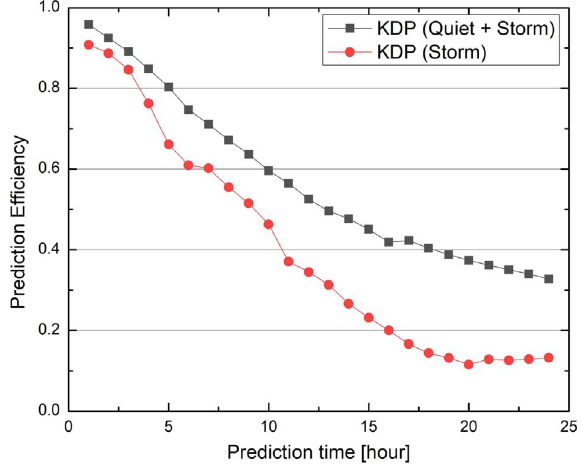
Fig. 10. Prediction ef fi ciency of KDP model for storm time only (red) and all test period (black).